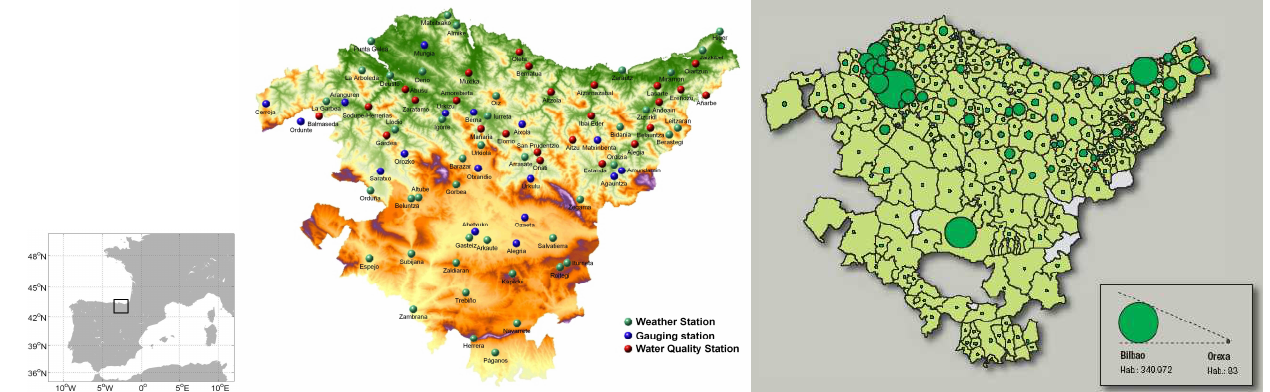
Figure 1. Basque Country Automatic Weather Station Network and population distribution. 3